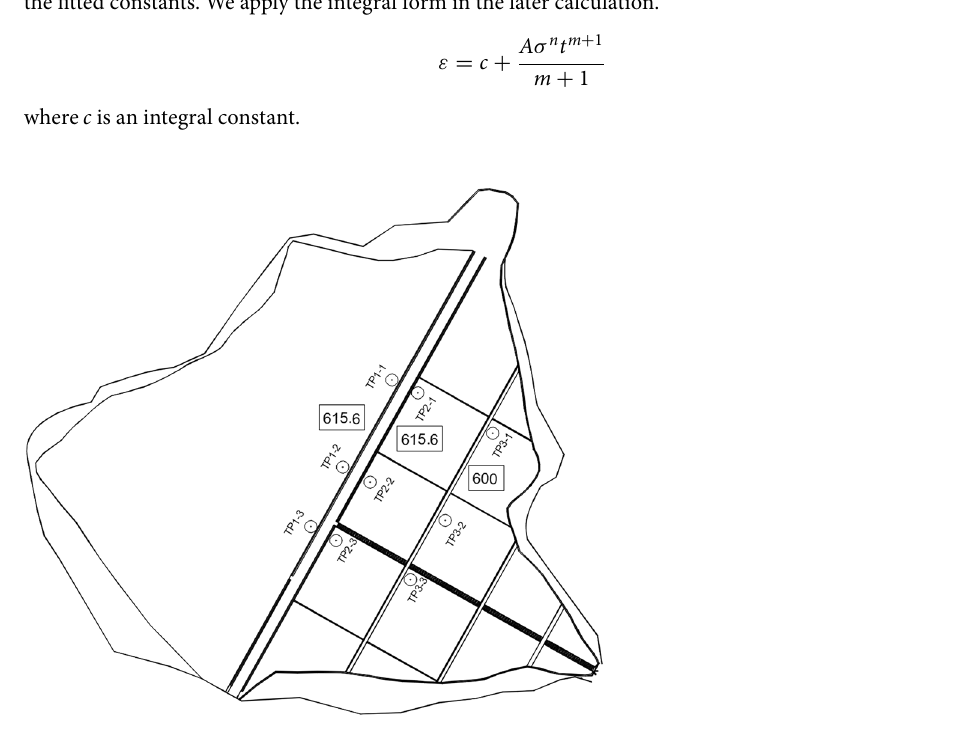
Figure 3. Layout of the controlled points (from TP1-1 to